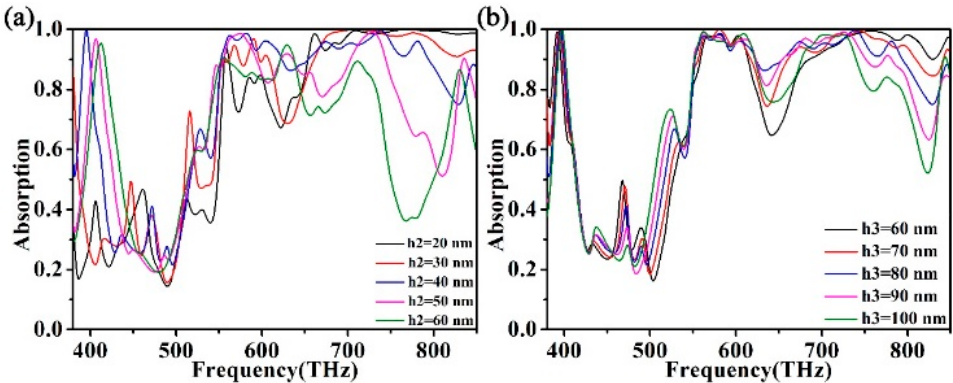
Figure 6. ( a ) The effect of dielectric layer thickness H2 on the absorption spectrum. ( b ) The effect of surface absorption layer thickness H3 on the absorption spectrum.